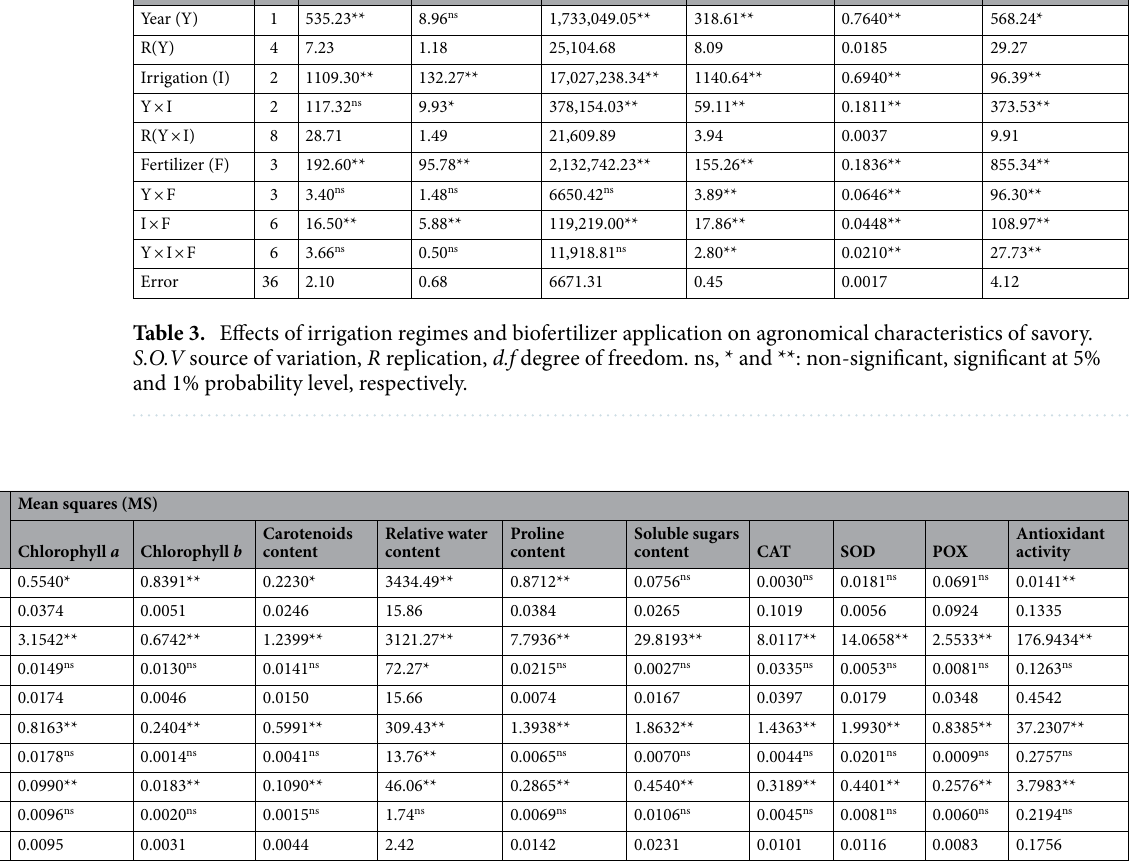
Table 4. Effects of irrigation regimes and biofertilizer application on physiological characteristics of savory. S.O.V source of variation, R replication, d.f degree of freedom. ns, * and **: non-significant, significant at 5% and 1% probability level,